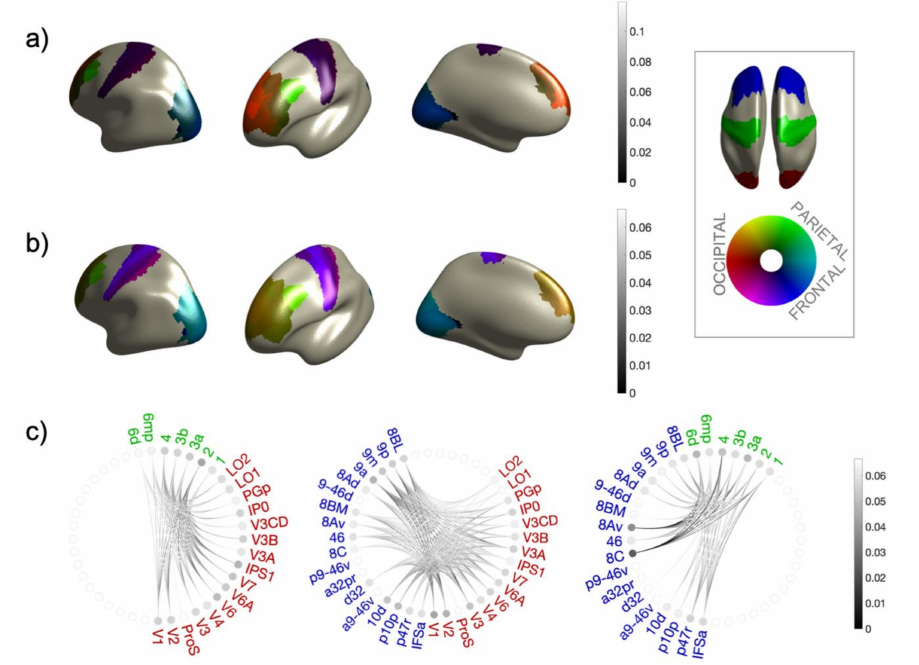
Figure 2. Results for WPPC connectivity. ( a ) Values of ∆ ( r a , B ) , for all sector combinations in color code. ( b ) Values of Γ ( r a , B ) , for all sector combinations in color code. ( c ) Connectome plots for the three relevant sector combinations computed from G. Red/green/blue ROI names belongs to occipital/parietal/frontal sectors respectively. The gray level of lines encodes the magnitude of Γ ( r Γ ( r a , r b ) while the gray level of the dot encodes a , B ) . In the inset the color code is explained: assigning red/green/blue colors to occipital/parietal/frontal sectors, respectively, the intensity of each area represents the overall magnitude of the parameter of interest, while the color encodes the proportion of the magnitude due to connectivity to the other sectors. So, for example, a parietal